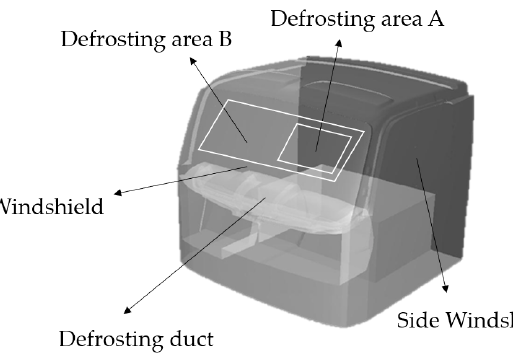
Figure 1. Three-dimensional computation domain model of the truck cabin.